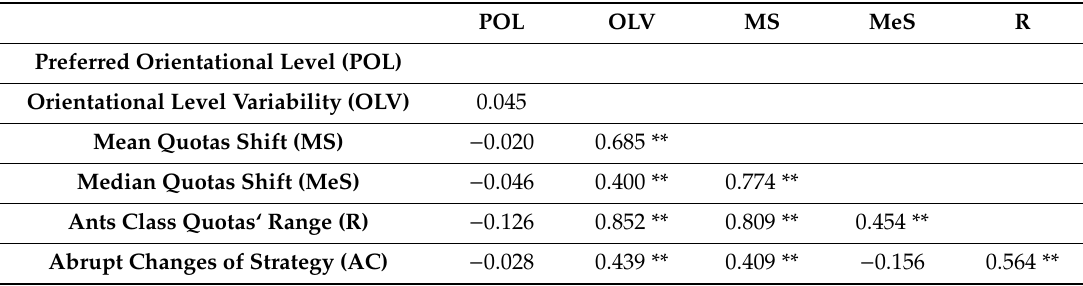
Table A4. Correlations between complex problem-solving strategies‘ parameters. POL OLV MS MeS R Preferred Orientational Level (POL) Orientational Level Variability (OLV) 0.045